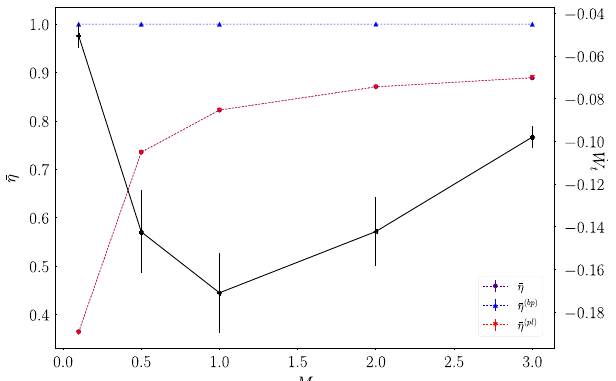
Figure 13. Macroscopic efficiency as a function of M l for ensembles of systems with p = 0.2 . The solid line plots the average power as a function of M l using a time window of t = 320 ¯ t c (note the corresponding scale on the right side of the